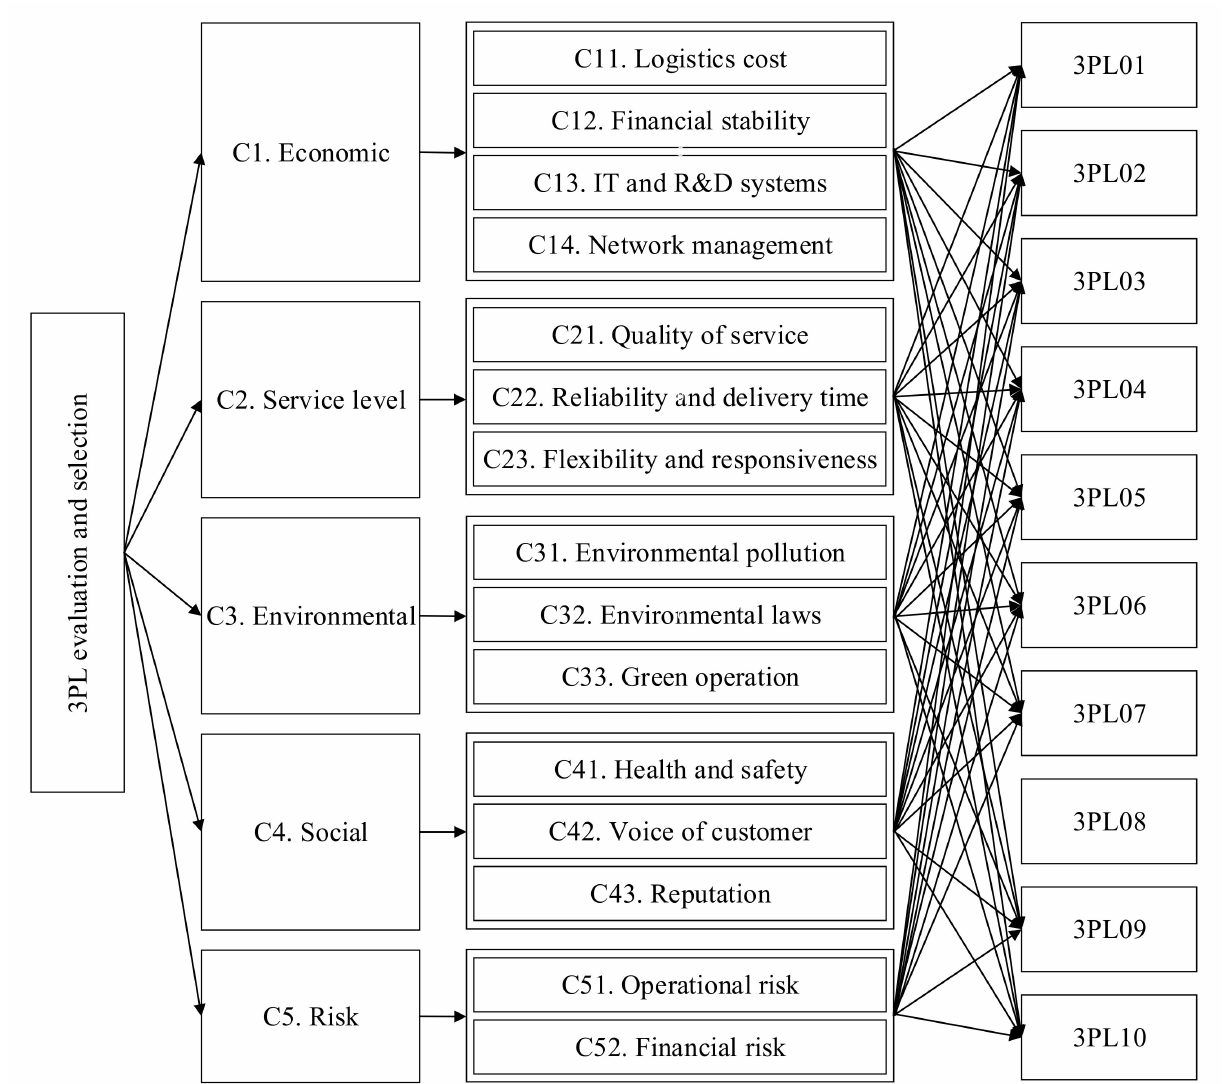
Figure 3. The decision hierarchy for choosing logistics